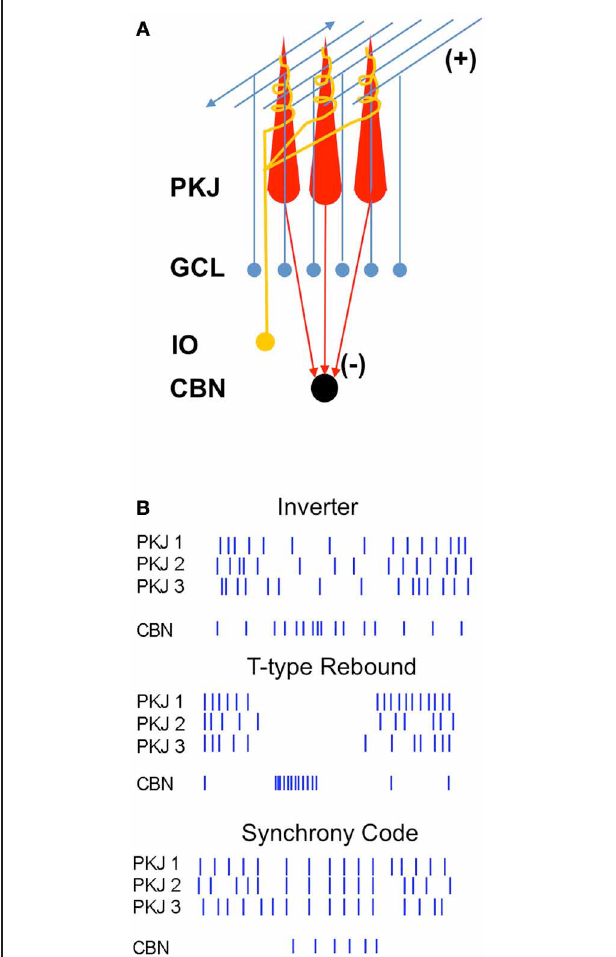
FIGURE 1 | Diagram of the corticonuclear circuit and mechanisms of corticonuclear signaling. (A) Cerebellar Purkinje cells (PKJ) receive glutamatergic inputs from the granule cell layer (GCL) whose axons form ascending inputs onto Purkinje cells and also ramify to form the parallel fibers, as well as from the inferior olive (IO), whose axons form the climbing fibers. Molecular layer inhibitory neurons are not shown. Purkinje cells form GABAergic synapses onto neurons of the cerebellar nuclei (CBN). (B) Schematized spike rasters showing the key features of three non-mutually-exclusive models of Purkinje cell regulation of nuclear cell firing. Nuclear cell spikes reflect responses to three afferent Purkinje cells. Inverter , nuclear cell firing rate varies inversely with Purkinje cell firing rate. T-type Rebound , nuclear cells are largely silenced by Purkinje cell activity, but fire bursts of action potentials driven by low-voltage-activated Ca currents when Purkinje cells stop firing. Synchrony code , nuclear cells are silenced by asynchronous inhibition but produce short-latency spikes after IPSPs from synchronous